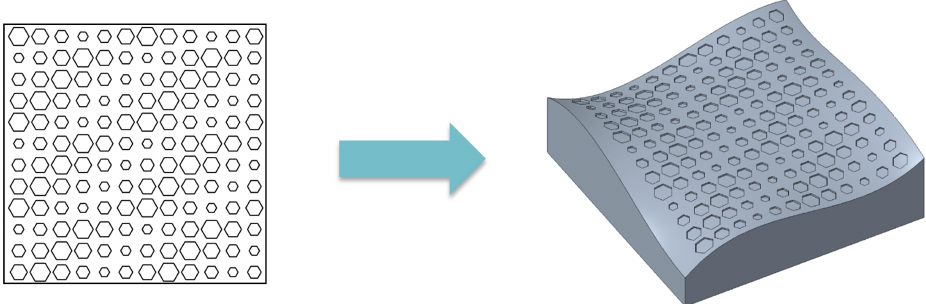
Figure 17. EmPatGen pattern on free form geometry.